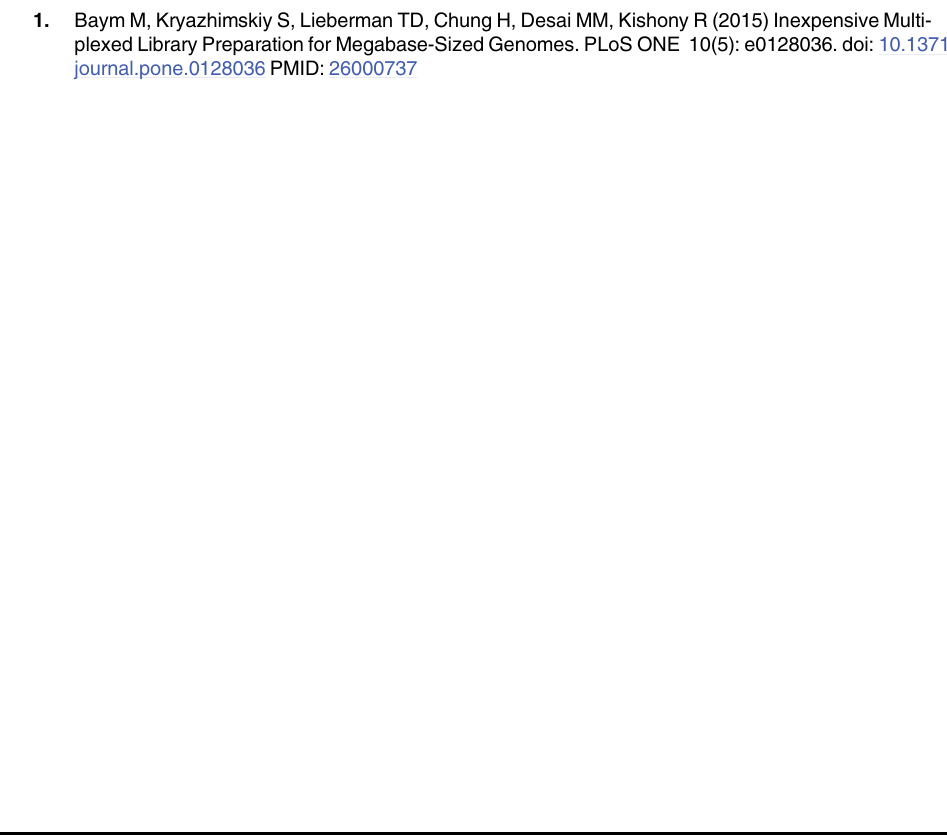
S2 Table. Data from two plates of E. coli samples. Plate number; measured post-PCR concen- trations of sample; and number, median, standard distribution, and histogram of aligned frag- ment sizes are